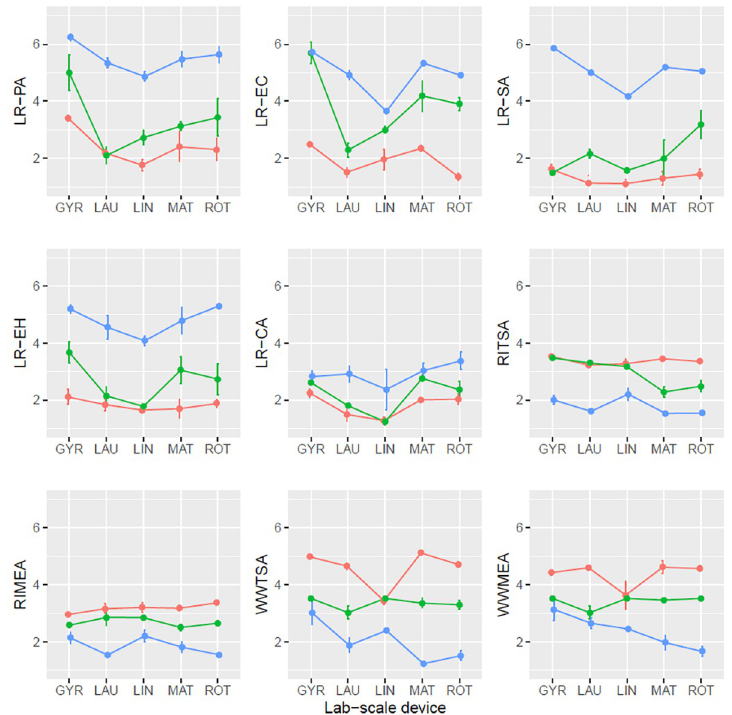
Fig 2. Mean plot with standard error bars of the different variables for main wash. Lines in blue: Concentration A; lines in green: Concentration B; lines in red: Concentration C. LR : Logarithmic reduction, PA : P . aeruginosa , EC : E . coli , SA : S . aureus , EH : E . hirae , CA : C . albicans , R I : Cross-contamination carrier, W W : Wash water, TSA : Trypticase soy agar, MEA : Malt extract agar, GYR : Gyrowash (James heal), LAU : Launderometer (SDL Atlas), LIN : Linitest (SDL Atlas), MAT : Labomat BFA-24 (Mathis